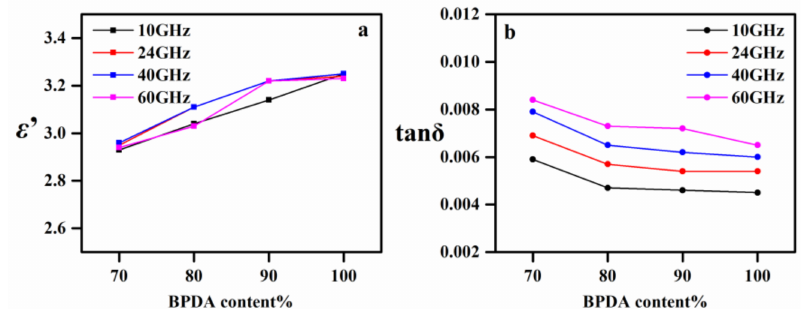
Figure 7. Dielectric constant ( a ) and dissipation factor ( b ) of the FAPI films at different high frequen- cies (10–60